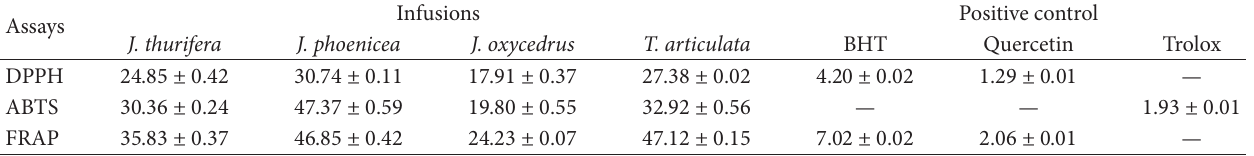
Table 2: IC 50 values ( 𝜇 g/mL) of J. thurifera, J. oxycedrus, J. phoenicea, and T. articulata infusions and of BHT, quercetin, and Trolox. Assays